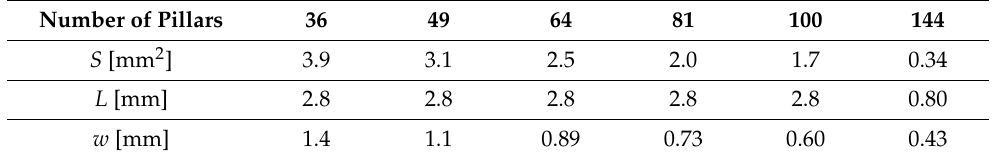
Table 1. Configuration of tested electrodes.